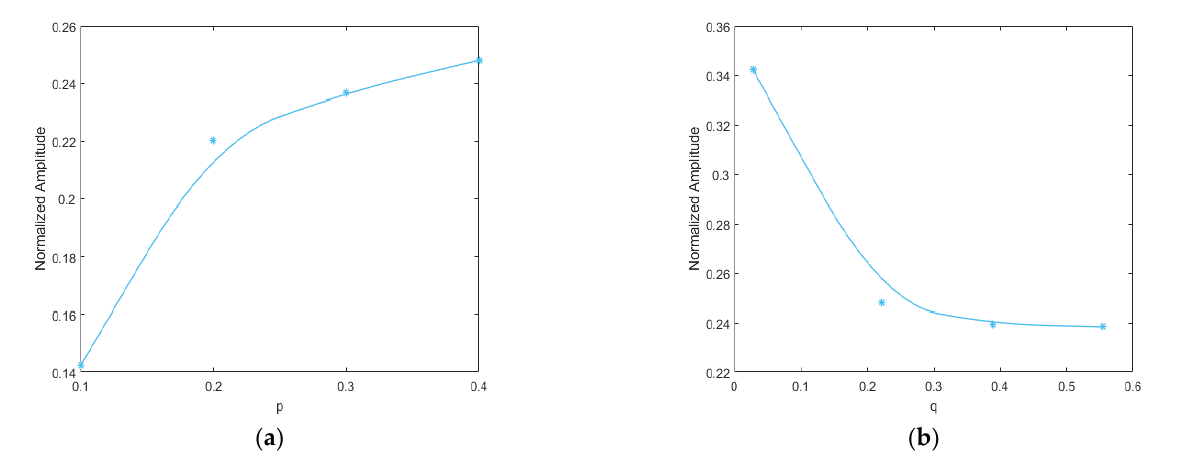
Figure 15. Variation trends of the second harmonic amplitude with ( a ) crack depth; ( b ) crack location.